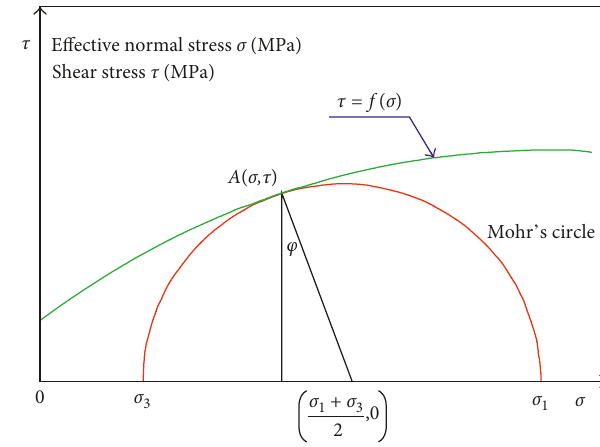
Figure 5: Schematic description of Mohr’s